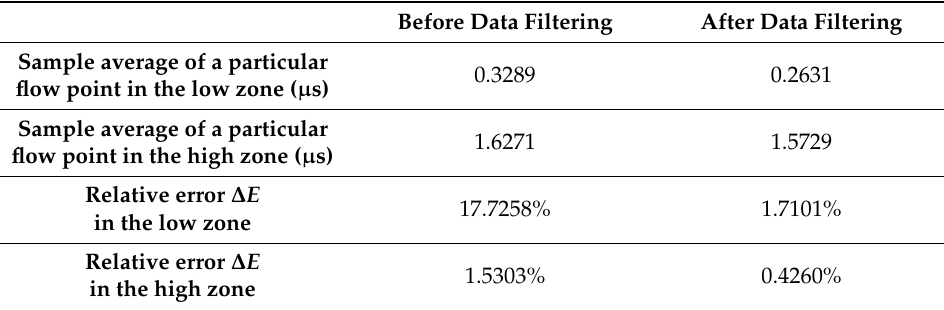
Table 5. Performance comparison with and without data